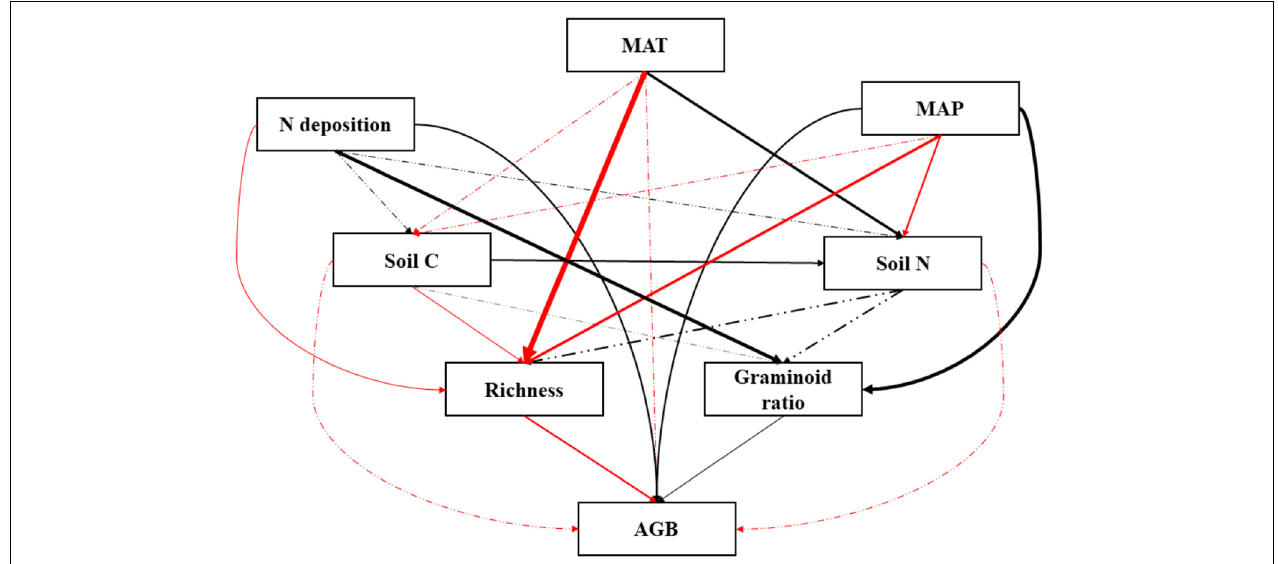
FIGURE 8 | Structural equation model (SEM) testing the relationships between community, soil, and climatic variables. Significant impacts are shown by solid lines whereas non-significant impacts are shown by dashed-dotted lines. Arrow width is proportional to the strength of the relationship. Positive impacts are shown in black and negative impacts are shown in red. MAT, mean annual temperature; MAP, mean annual precipitation; Soil C, soil carbon content; Soil N, soil nitrogen content; AGB, aboveground biomass. χ 2 = 3.066, P = 0.382, GFI = 0.979, NFI = 0.989, RMSEA =